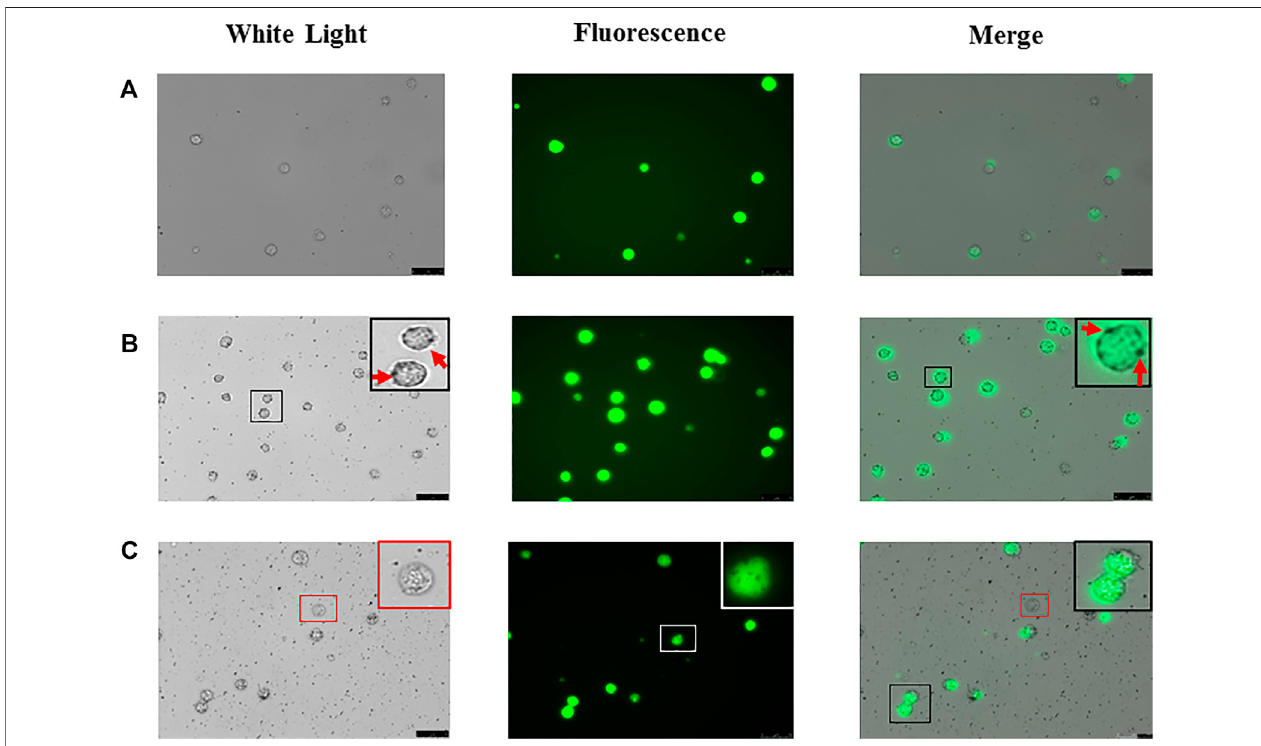
FIGURE 3 | Foundation of “ nano ring ” in bladder tumor cells. (A) Biu-87 cells show green fl uorescence. (B) Incubate fl uorescent Biu-87 cells with positive mNPs, cells were surrounded by the mNPs (red arrows). (C) Mix the same number of fl uorescent Biu-87 cells, SVHUC cells, and positive mNPs; mNPs only surround green fl uorescent Biu-87 cells (black frame), and no NPs surround the only cell without fl uorescence (red frame).